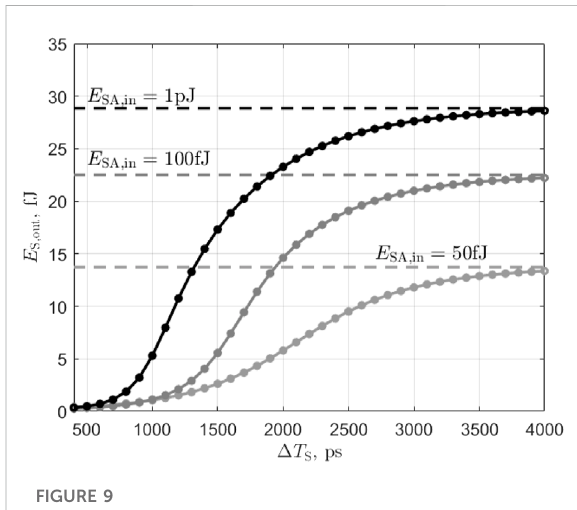
FIGURE 9 Simulation of output pulse energy as a function of SA input pulses energyfor differentdelaysbetweentheinput pulses andfor i bias = 13 mA. The laser receives two input pulses (SA section) of equal energy E SA,in separated by Δ T S . In response it emits up totwooutputpulses.The fi rstoutputpulseenergyisplottedwitha dash line while the second pulse energy is plotted with a thick line and symbols.